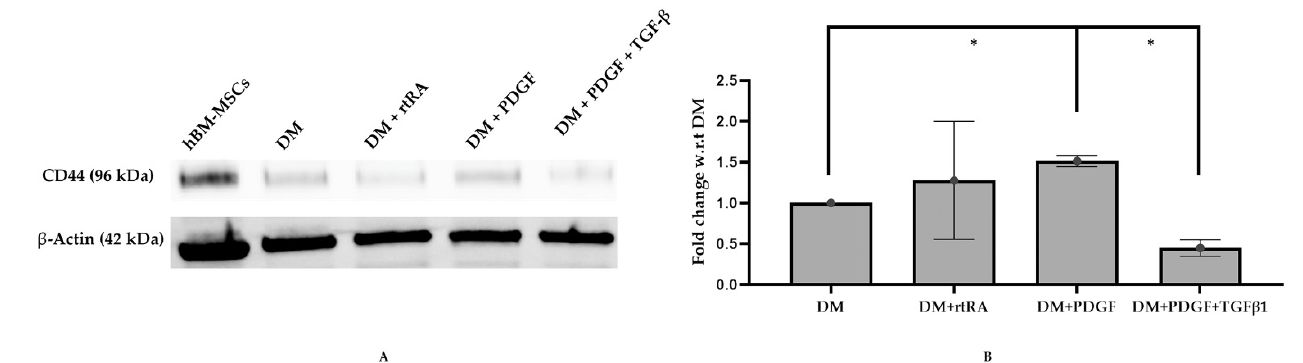
Figure 2. Western blot analysis of MSC marker of M3 cell line subjected to different DM treatments. Treated hBM-MSCs were plated onto fibronectin-coated T175 flasks and treated for 4 days with DM, DM + atRA, DM + PDGF, and DM + PDGF + TGF- β 1. Western blot analysis was performed for stem cell marker CD44 ( A ) and normalized to β -actin. Fold change was determined with respect to DM treatment ( B ). The treatment supplemented with PDGF and TGF- β 1 (DM + PDGF + TGF- β 1) showed a statistically significant decrease in CD44 expression when compared to DM (*- p -value < 0.05) ( B ). The treatment supplemented with PDGF (DM + PDGF) showed a significant increase in CD44 expression when compared to DM (*- p -value < 0.05) ( B ). Table 1. Application of three different growth factor-based DM treatments for a time point of four and seven days on three different bone marrow-derived stem cell lines. N/A in column 4 refers to results where none of the cell line samples in DM medium could show a higher expression of MYH11 than cell lines grown in CCM. Only PT (semi-batch) and PT treatment could elicit MYH II expression greater than CCM control in at least one